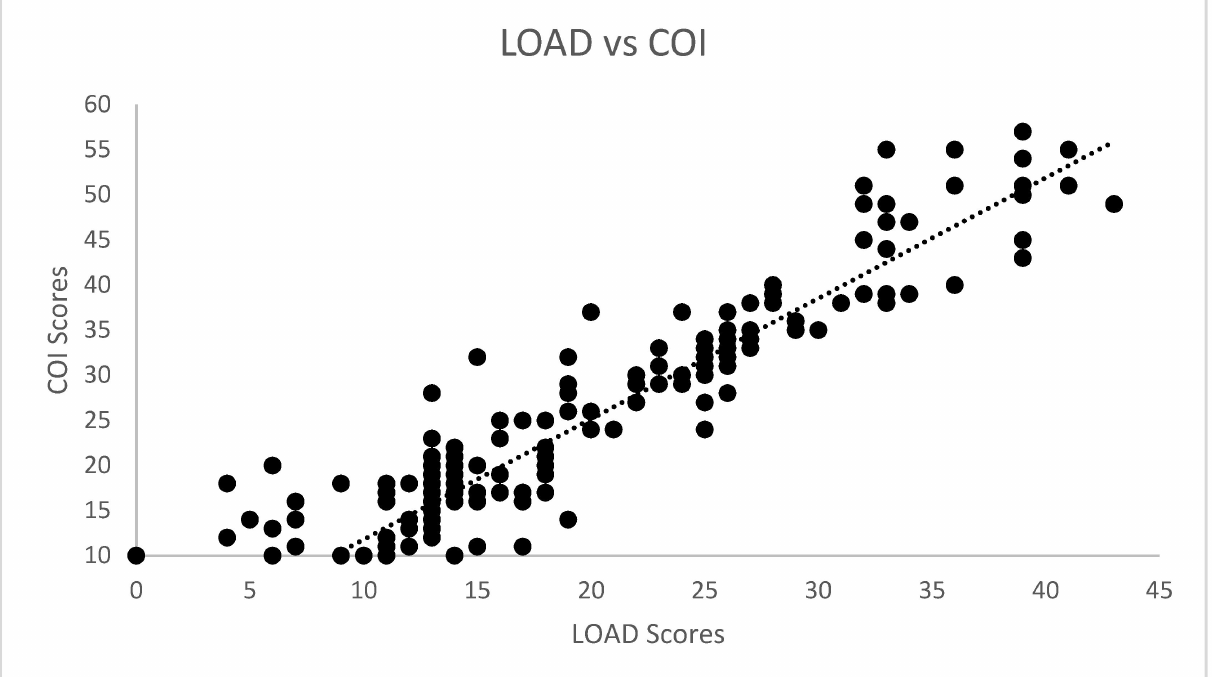
Figure 5. Scatterplot of LOAD (Liverpool Osteoarthritis in Dogs) and COI (Canine Orthopaedic Index) in the longitudinal cohort. A significant strong correlation was observed (r = − 0.954, p < 0.01). Comparing CMI results, Mauchly’s test rejected the presence of sphericity ( χ 2(35) = 5189, p < 0.01). The difference between mean scores was significantly differ- ent, with F(1.18, 320,548) = 257,845, p < 0.01. Cronbach’s α was 0.80 for HVAS, 0.98 for CBPI, 0.97 for PIS, 0.98 for PSS, 0.97 for LOAD, 0.98 for COI, 0.97 for stiffness, 0.97 for function, 0.96 for gait and 0.85 for QOL. Kaiser–Meyer–Olkin factor analysis was 0.88 for HVAS, 0.94 for CBPI, 0.96 for LOAD and 0.96 for COI. As all values were above 0.8, factor analysis was conducted for the four CMIs. Scree plots for HVAS, CBPI, LOAD and COI are presented in Figures 6–9, respectively. For HVAS, two factors with eigenvalues >1 were extracted. These factors accounted for 60.2% and 13.3%, respectively, of the total variance. Based on the varimax-rotated solution, loading for these items was performed. All items loaded heavily on the first component, with communalities ranging between 0.68 and 0.91. For the second component, not all items demonstrated significant communalities, with values ranging from − 0.39 to 0.65. For CBPI, a single factor was extracted, which accounted for 90.9% of total variation. All other items loaded heavily on this component, with communality being >0.93. For LOAD, two factors were extracted and were responsible for 76.1% and 10.5% of the total variance, respectively. Other items loaded mainly on the first component, with communalities ranging from 0.71 to 0.94. For COI also was only one factor extracted, accounting for 79.5% of total variation. All other items loaded on this component, with communalities ranging from 0.46 to